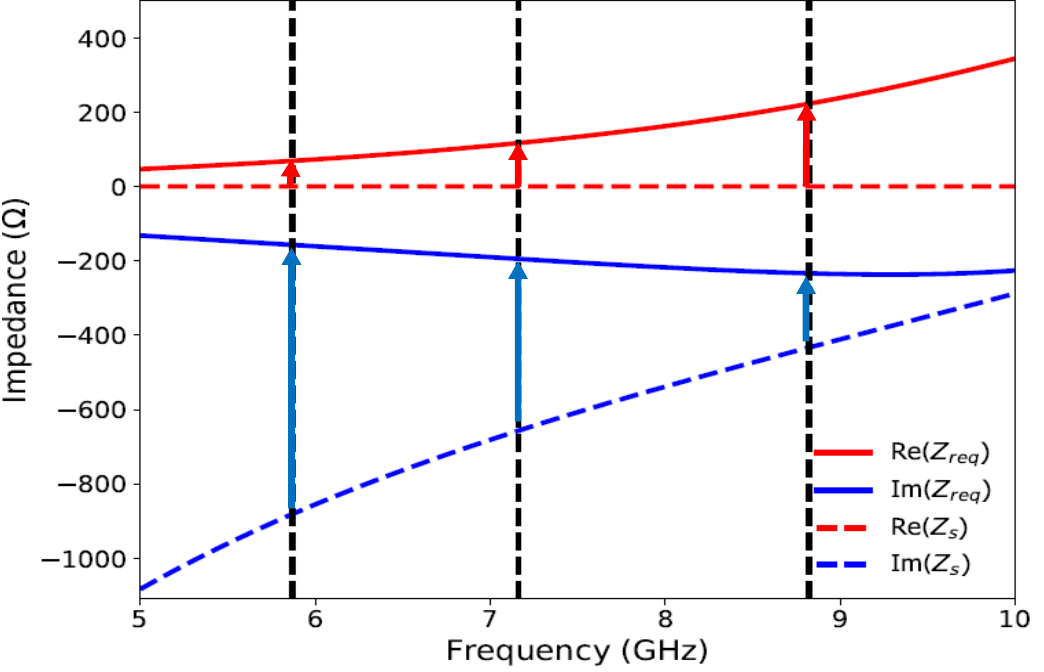
Figure 5. Required real (Re( Z req )) and imaginary (Im( Z req )) parts for perfect absorption and real (Re( Z s )) and imaginary (Im( Z s )) parts of the impedance of the